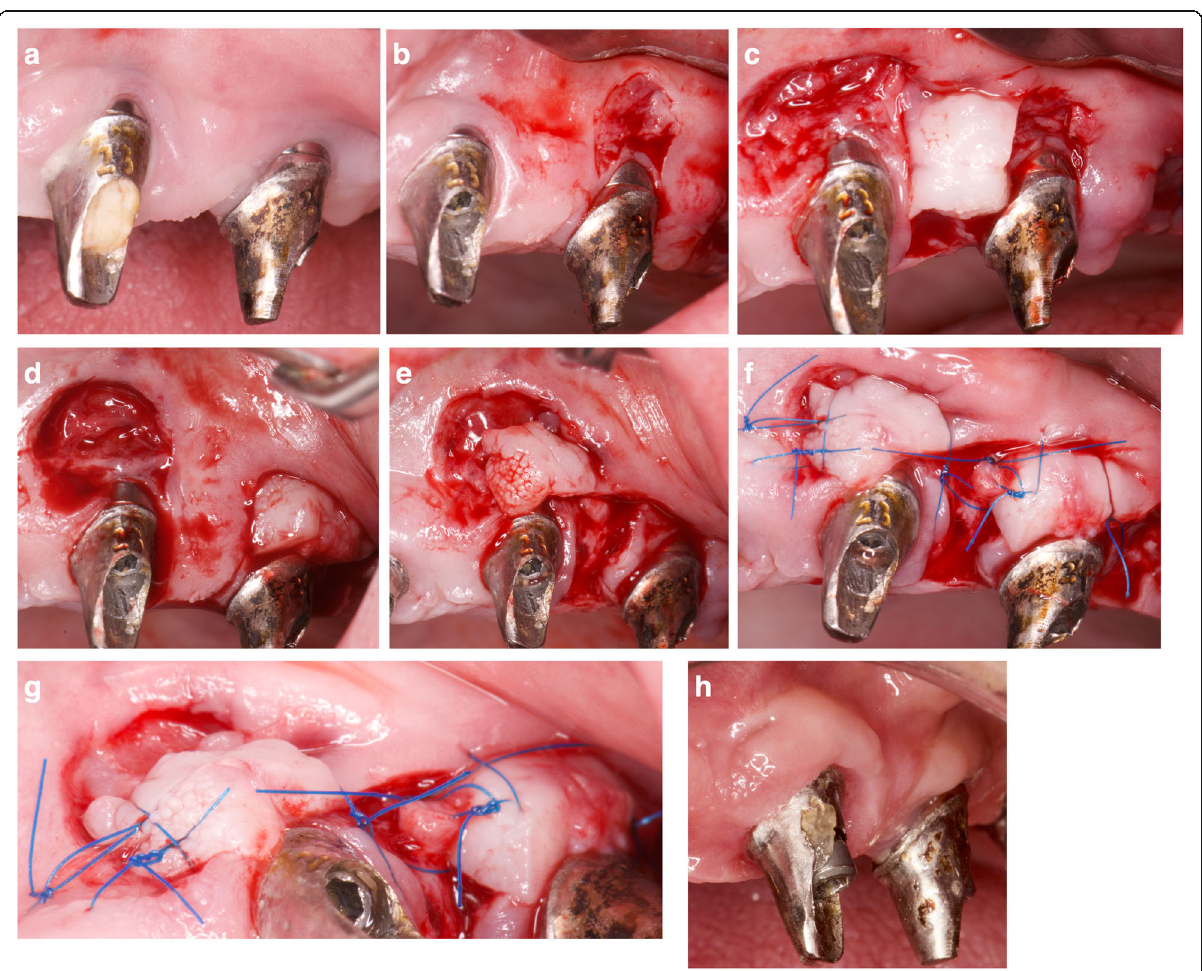
Fig. 2 Laterally rotated flap sequence. a Poor peri-implant soft tissue quality and volume. b A pediculated graft in prepared in the distal aspect of the distal implant. The receptor area is prepared on the buccal aspect of the distal implant. c Recipient bleeding and firm areas in both implants and pediculated flap prepared from the distal aspect. d Schematic illustration. The pediculated graft is laterally rotated 90° over the recipient site. e Recipient bleeding and firm areas in both implants and pediculated flap prepared from the distal aspect. f , g Pediculated flaps in passive position and without tension over the recipient sites. h Sutures. Frontal and occlusal view. i Twelve months